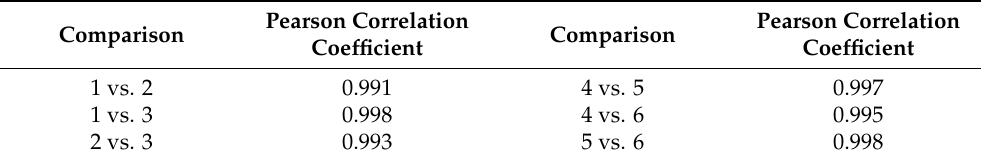
Table 5. Spectral comparison of kidneys. The spectra of kidneys as a function of race, sex, body weight, and ischemia time were examined using normalized cross-correlation. The assignment of the numbers can be found in the previously listed table.